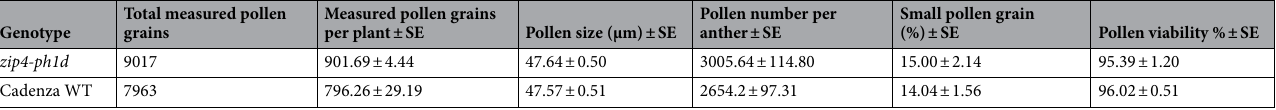
Table 1. Summary of pollen analysis data for zip4-ph1d mutant and wild type (WT) wheat Cadenza.